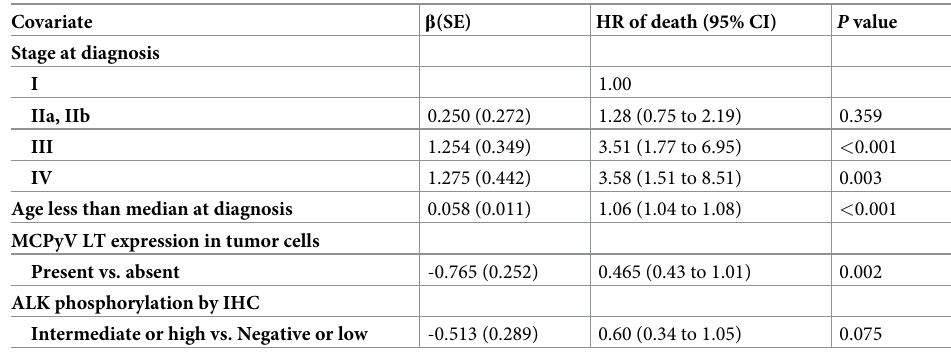
Table 4. Multivariable Cox hazards analysis on overall